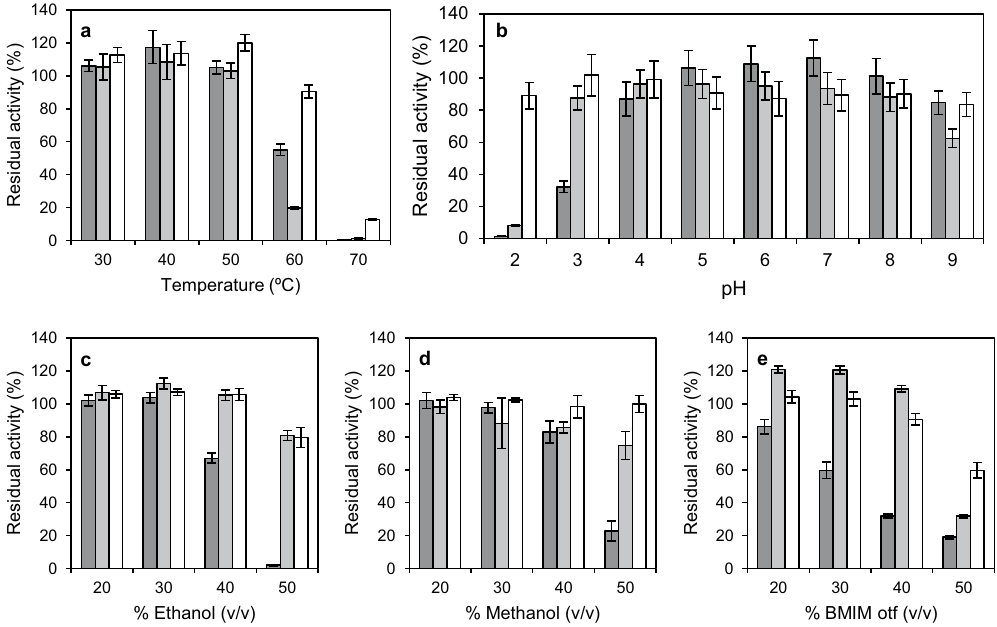
Figure 2. Long-term stabilities of domain-swap laccase and OB1 and 3PO parent-type laccases. Residual activities after 6-h incubation at different temperatures ( a ), pH ( b ) or solvent concentrations including ethanol ( c ), methanol ( d ) or BMIM otf ( e ). From left to right: OB1, 3PO and domain-swap laccases. Error bars indicate standard deviation for